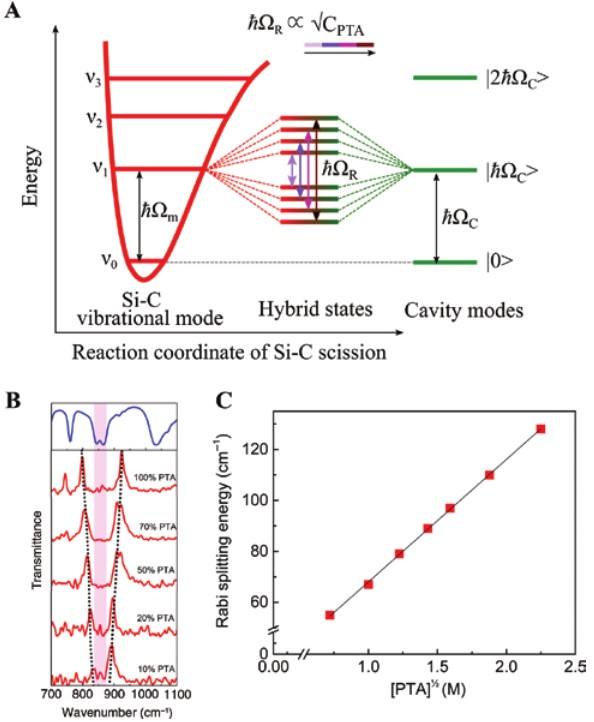
Figure 1: Formation of polaritonic states and VSC of Si–C stretching modes of PTA. (A) Schematic illustration of the formation of polaritonic states P + and P− and the modulation of Rabi splitting energy as the concentration of PTA ( C ) is varied. (B) FT-IR transmission spectra PTA showing the vibrational modes of PTA in methanol (blue curve) and the Rabi splitting corresponding to the VSC of the Si–C stretching modes as a function of C . The shaded region shows the width of PTA the Si–C stretching vibration, and the dotted lines are guide to the eyes. (C) The plot showing the linear dependence of Rabi splitting energy on the square root of C PTA